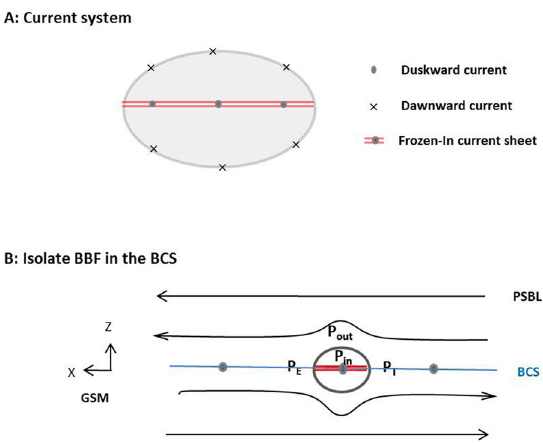
Figure 5. A schematic of current system of the BBF in the CSFI model and its motion in the background plasma sheet. ( A ) View on the closed current system of the fast flow confined current sheet in the meridian profile. ( B ) Motion of the BBF dependence on pressure gradient in the tail plasma